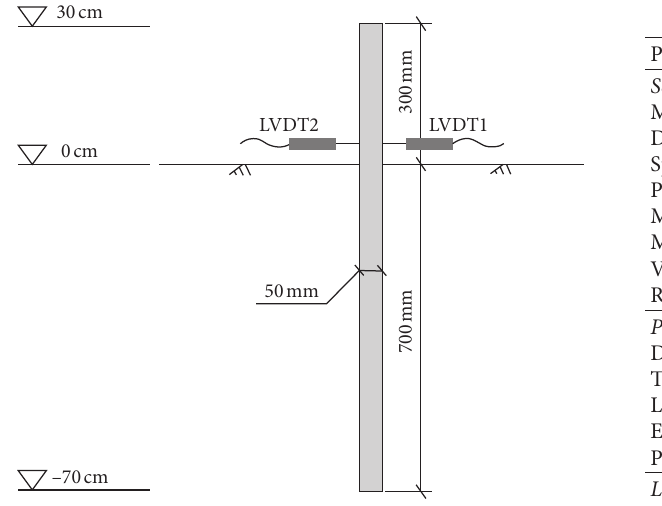
Figure 1: Layout of model pile.